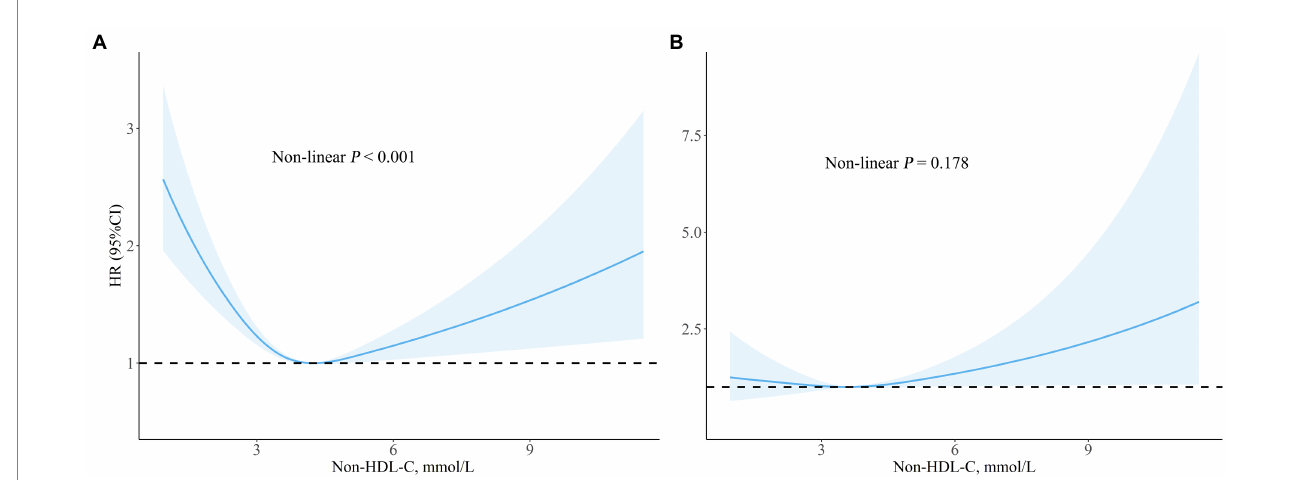
FIGURE 2 Spline analyzes of all-cause (A) and cardiovascular (B) mortality by non-HDL-C in the overall cohort (Spline analyzes were adjusted for age, gender, race, smoking, family income, education level, physical activity, body mass index, systolic blood pressure, estimated glomerular filtration rate, comorbidities (diabetes and hypertension), and medicine use (antihypertensive drugs, hypoglycemic agents, and lipid-lowering drugs.